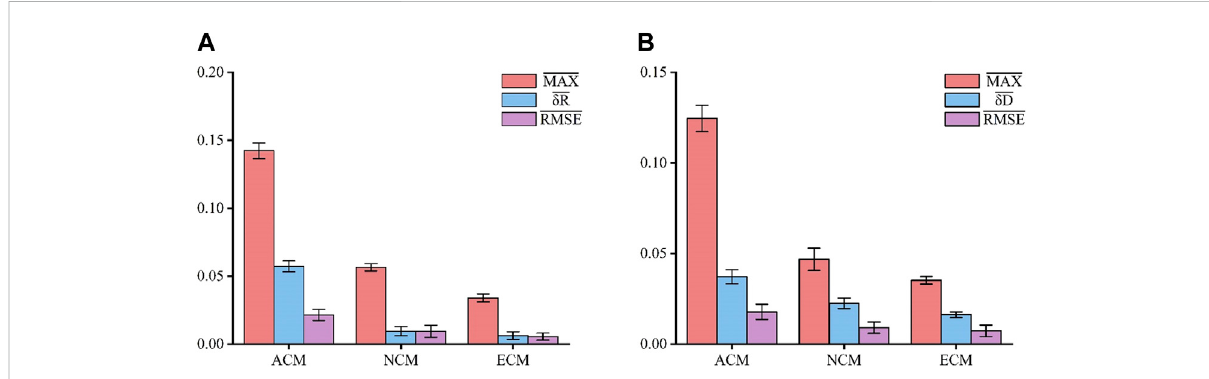
FIGURE 4 The calibration performance comparison of three calibration methods with different samples, (A) a wave plate sample, (B) a polarizer sample.